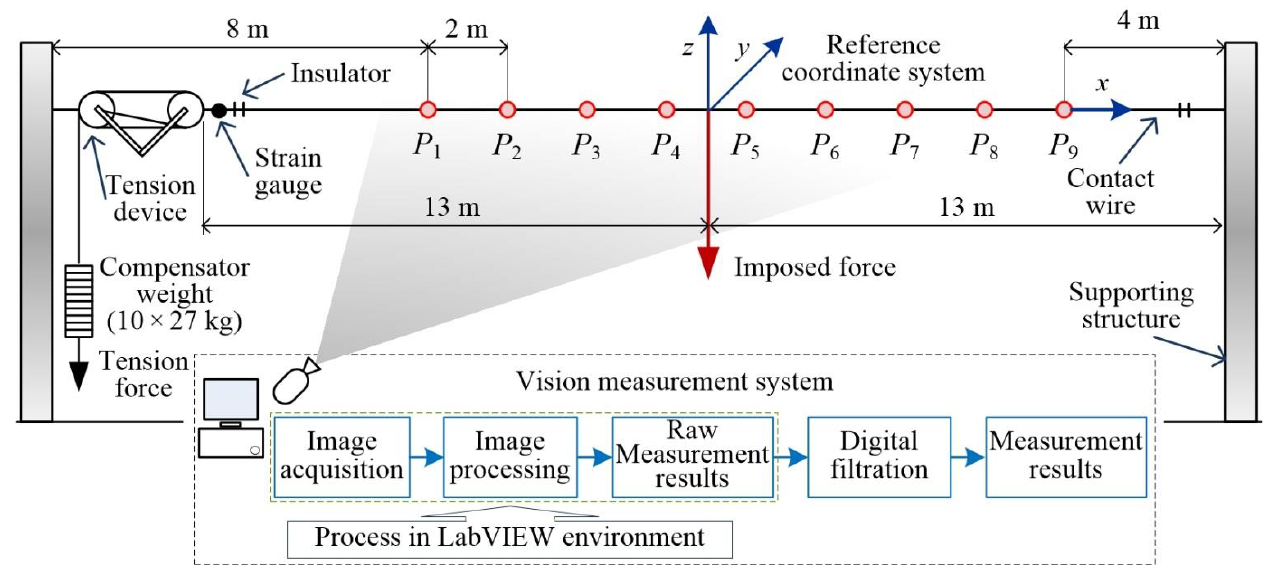
Figure 8. Scheme of the test stand, where P 1 , … P 9 – light points.